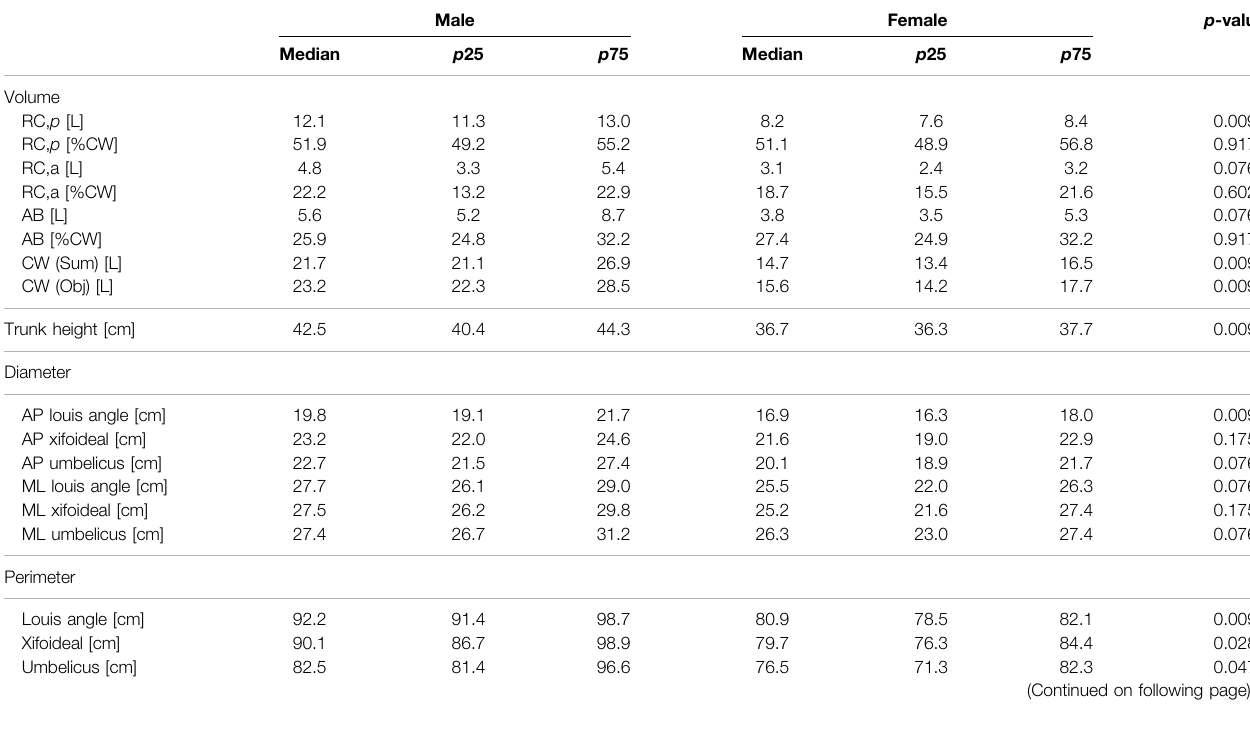
TABLE 2 | Chest wall geometry at functional residual